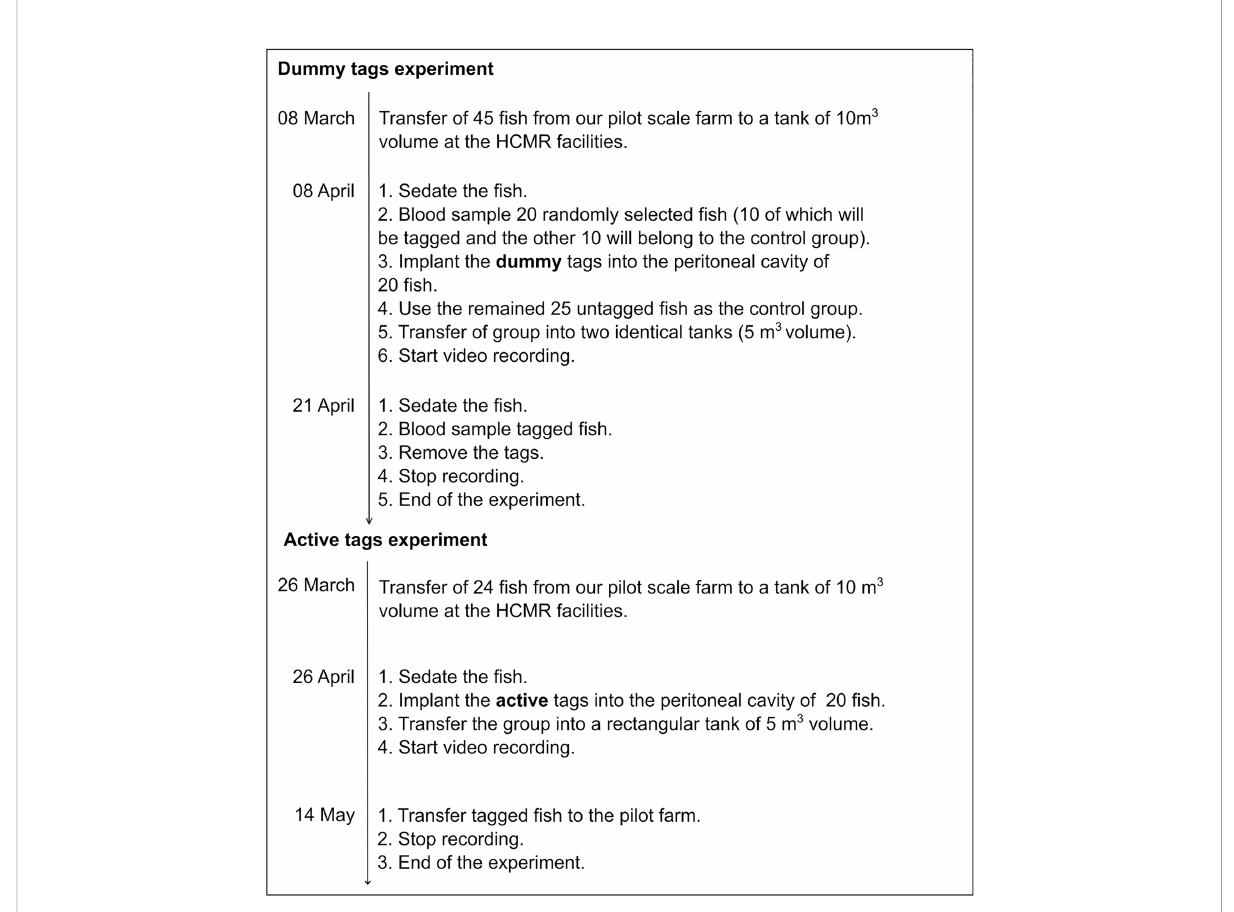
FIGURE 1 Timeline of the main steps followed in the experiments of the dummy and active